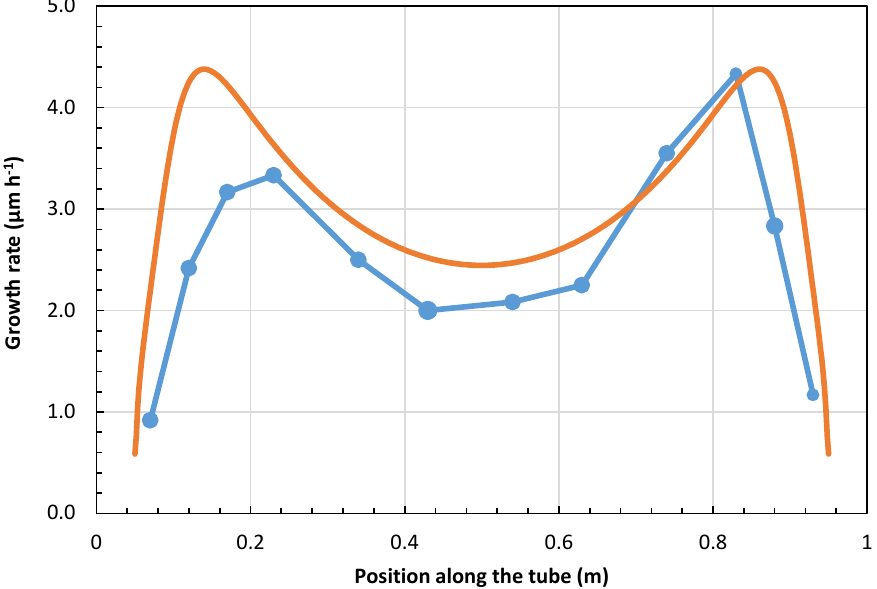
Figure 9. Calculated ( − ) and experimental ( ) growth rate of CrC x coatings along the inner wall of the tube reactor 1 m long with the injection of the precursor successively and alternately at each end ( T = 400 ◦ C; P = 1.3 × 10 3 Pa; duration = 2 × 3 h; 500 sccm N 2 ; injection of 0.5 g min − 1 of precursor solution in toluene containing 10.3 wt. % of bis(ethylbenzene)chromium (BEBC)).